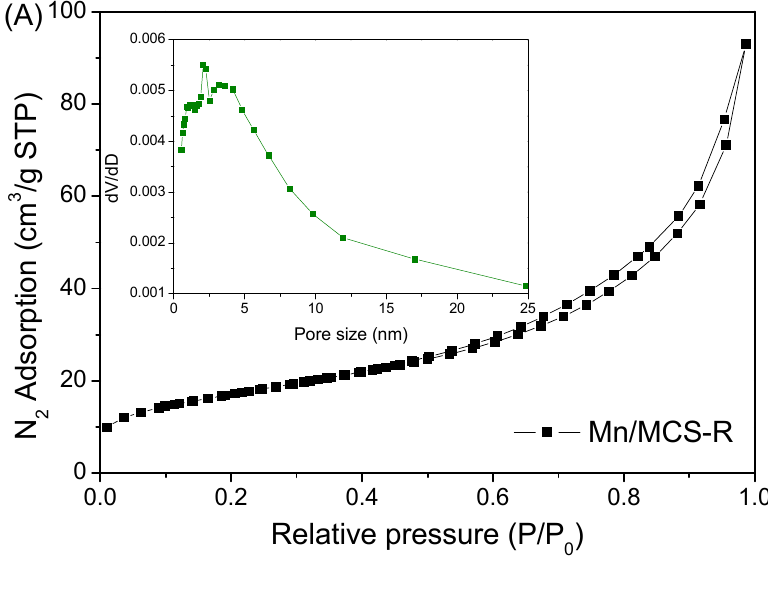
Figure 3. X ‐ ray diffraction (XRD) patterns of various Fe 3 O 4 /C/Mn hybrids.